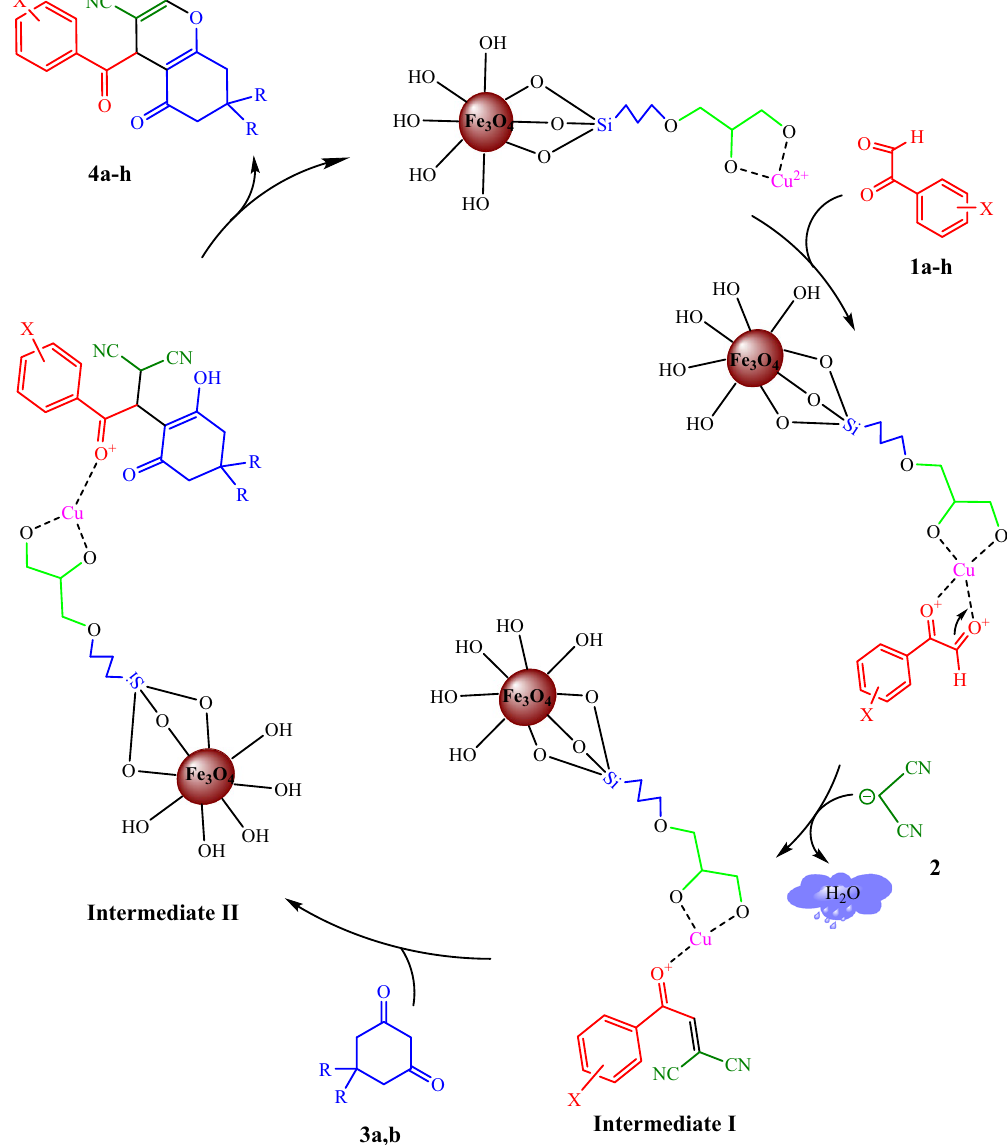
Figure 10. The possible mechanism for the obtaining of compounds 4a–h .